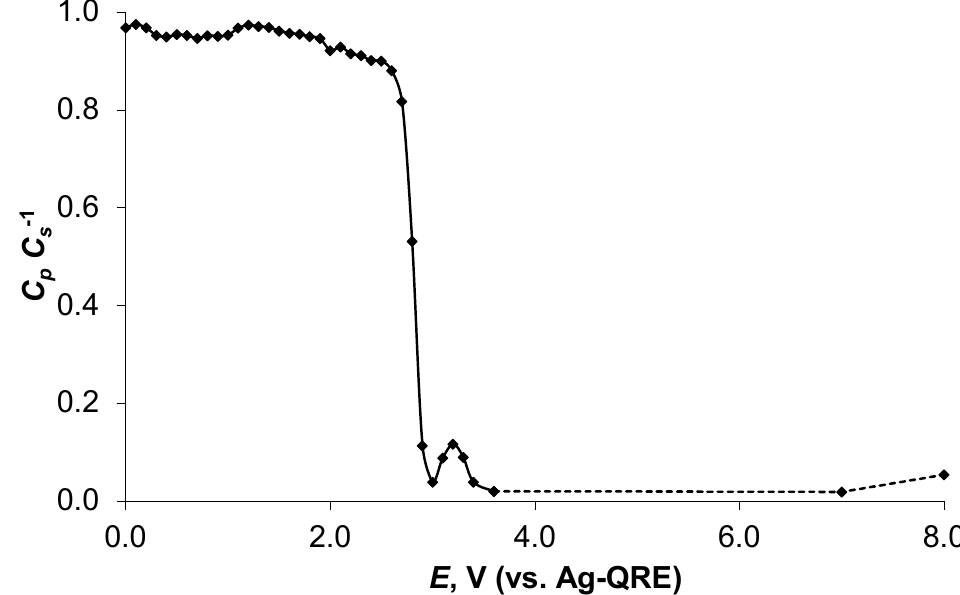
Figure 8. The ratio of parallel ( C p ) and series ( C s ) capacitance ( C p C s − 1 ) vs. Al-electrode potential ( E ), applied; relationship at the electrochemical-impedance-spectroscopy modulation frequency of 0.10 Hz.